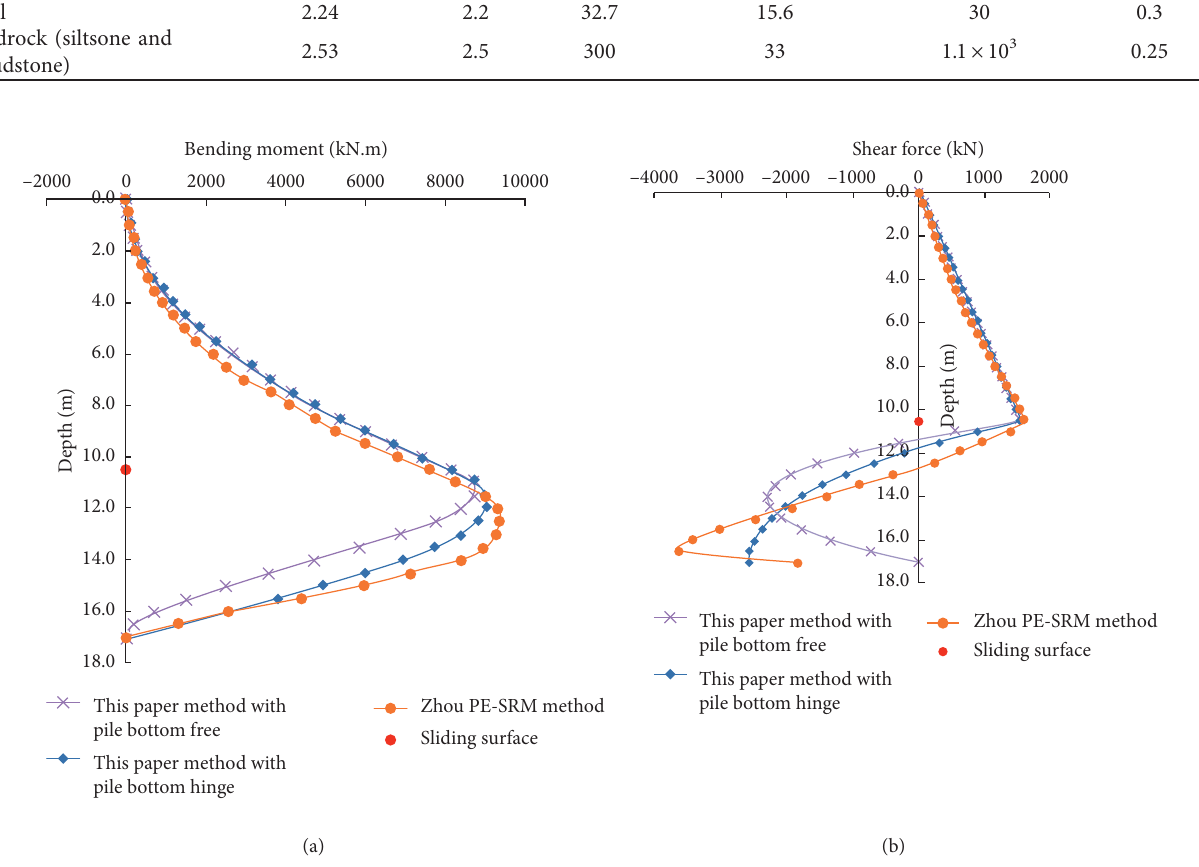
Figure 2: Calculated values of internal forces of the pile using various methods. (a) Shear force. (b) Bending moment.